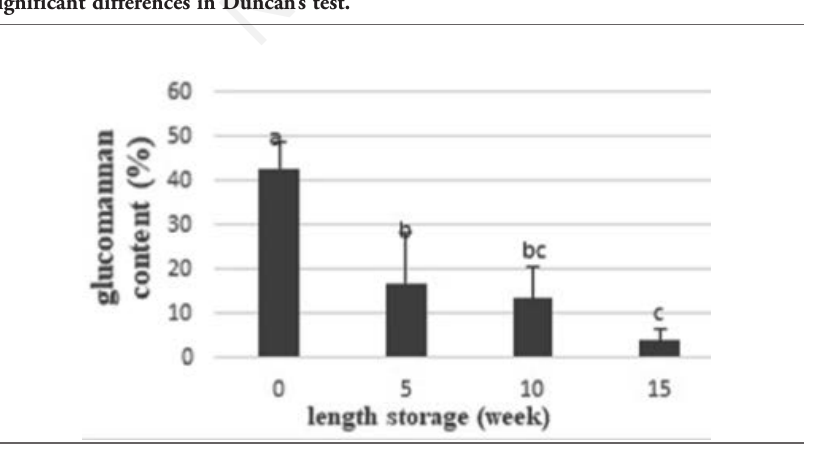
Figure 6. Glucomannan content of the edge and the center of the tubers. From edge and center part of tuber. Different letters indicate significant differences in the t test at α